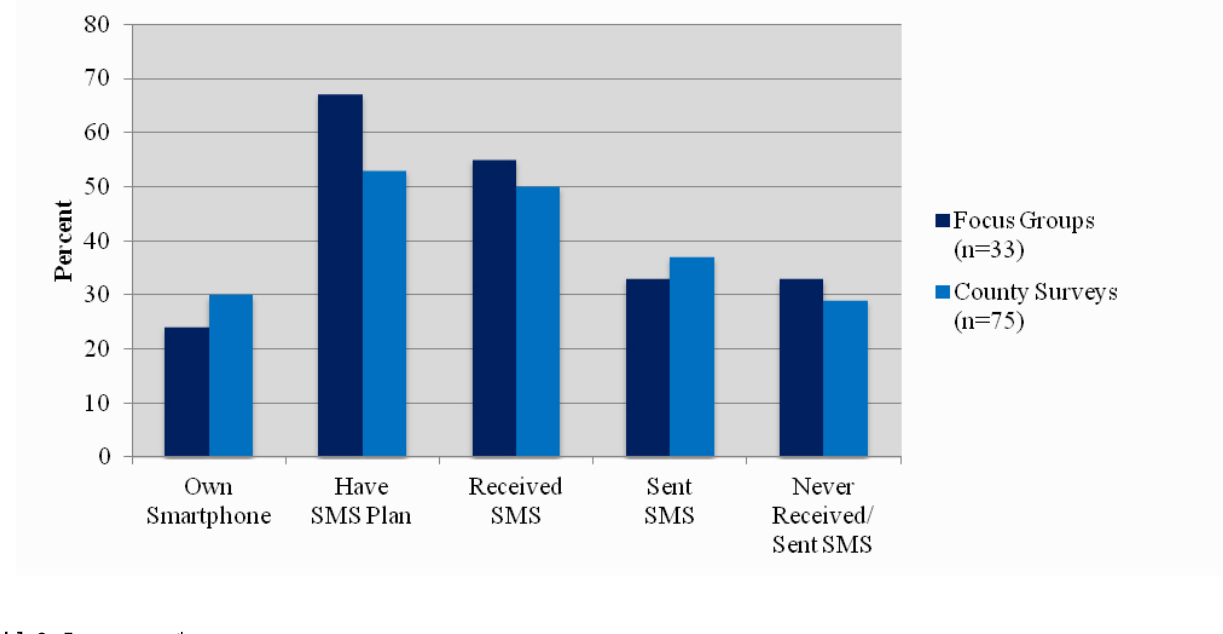
Figure 1. Smartphone ownership and SMS usage among participants owning a mobile phone.